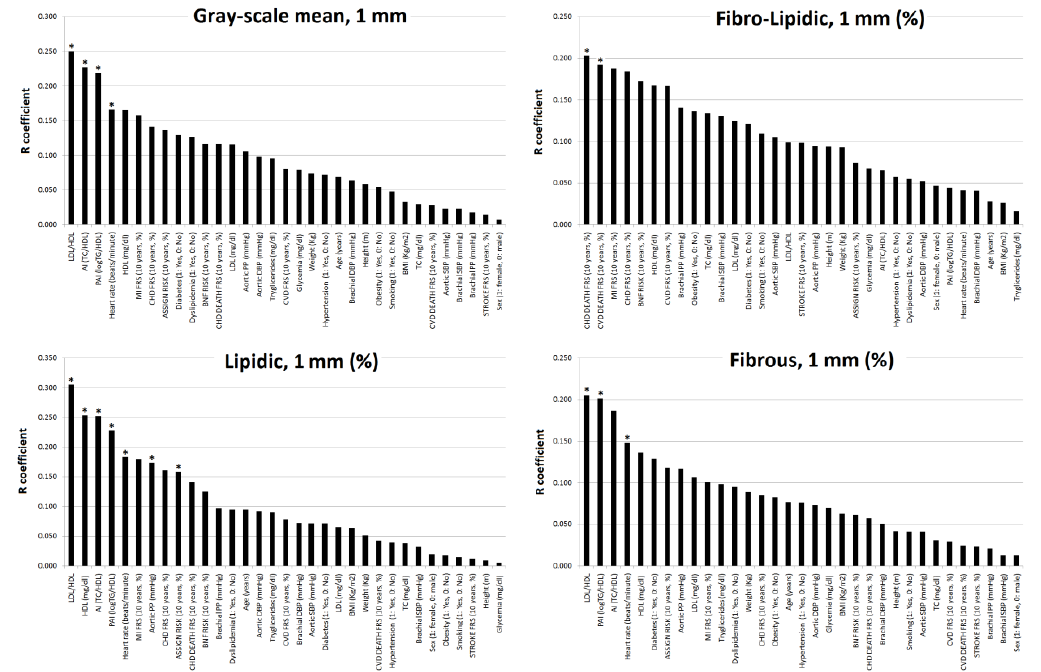
Figure 5. Strength of association (correlation coefficient absolute value, R) between subjects´ characteristics and composition of the plaque 1st mm ( n = 206). * p < 0.05.